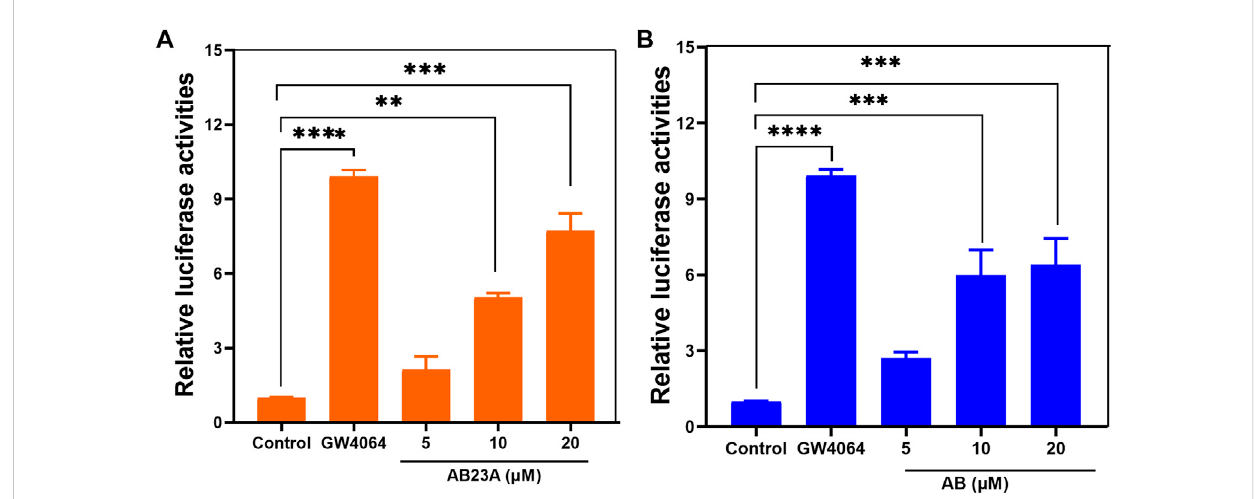
FIGURE 6 ThetranscriptionalactivationassaysofAB23A (A) andAB (B) .HEK293TcellswerecotransfectedwithphFXRexpressionplasmid,andFXR-dependent reporter (EcRE-LUC) and treated with the FXR agonist GW4064 (10 μ M), control (DMSO), AB23A and AB (5, 10, 20 μ M) for another 48 hours. The relative luciferase activities were measured by comparison with renilla luciferase activities. The maximum ef fi cacy of the positive agonist (GW4064) is arbitrarily set at 100%. Compared with the control group, **** p < 0.0001 *** p < 0.001, ** p <